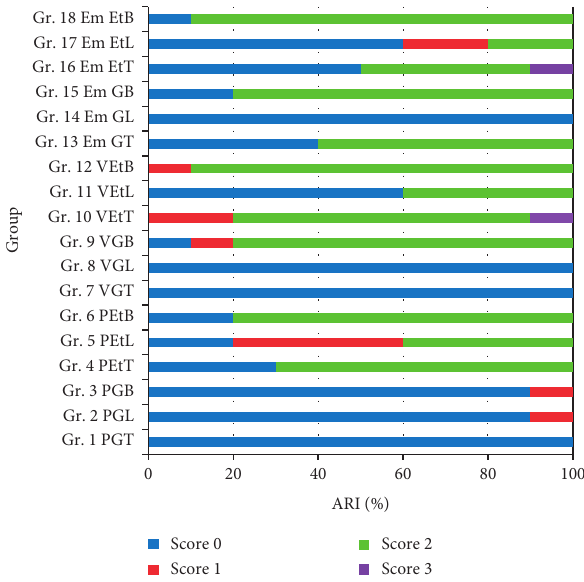
Figure 5: Frequency distribution (%) of type of Adhesive Remnant Index (ARI)